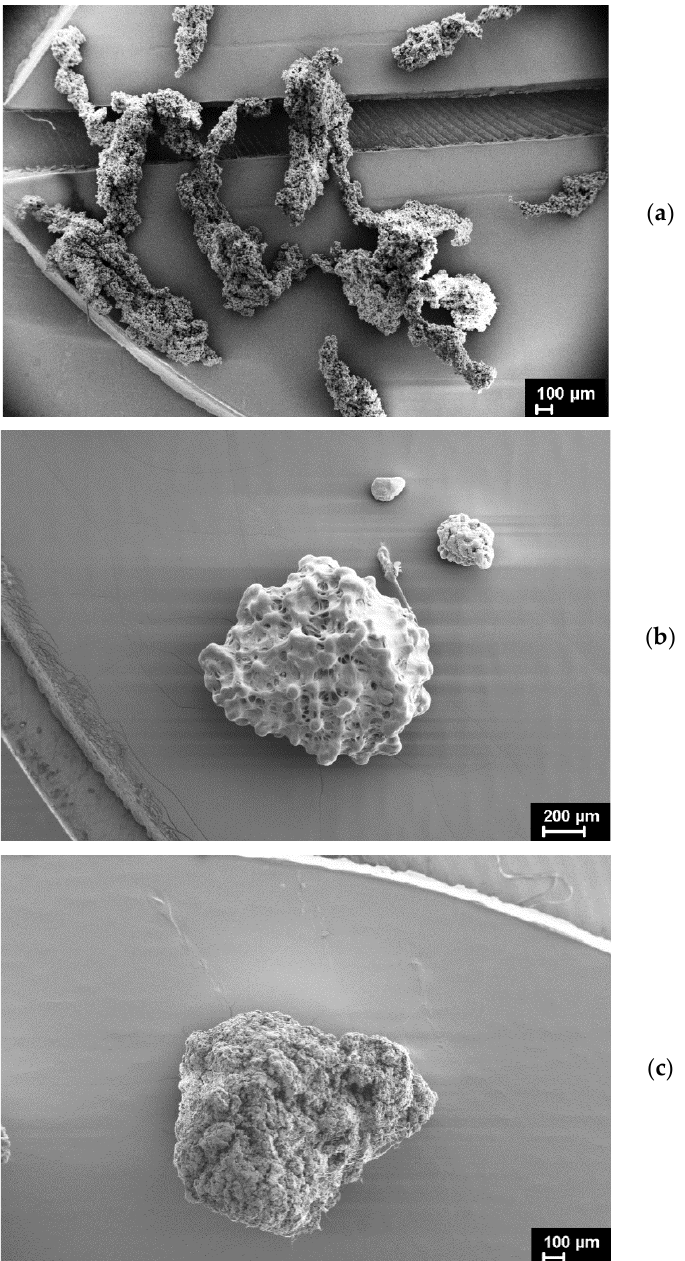
Figure 1. The micrographs of UHMWPE reactor powders: IVA7 ( a ), Lupolen ( b ), and SC ( c ).